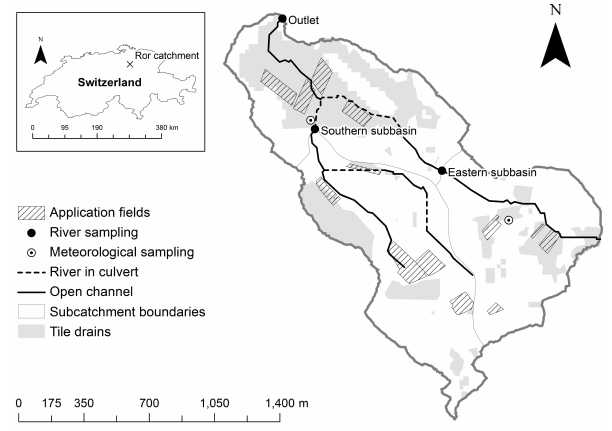
Fig. 1. The Ror catchment with pesticide application fields and artificially drained areas (swisstopo (Art. 30 GeoIV): 5704 000 000/DHM@2003, reproduced with permission of swis-